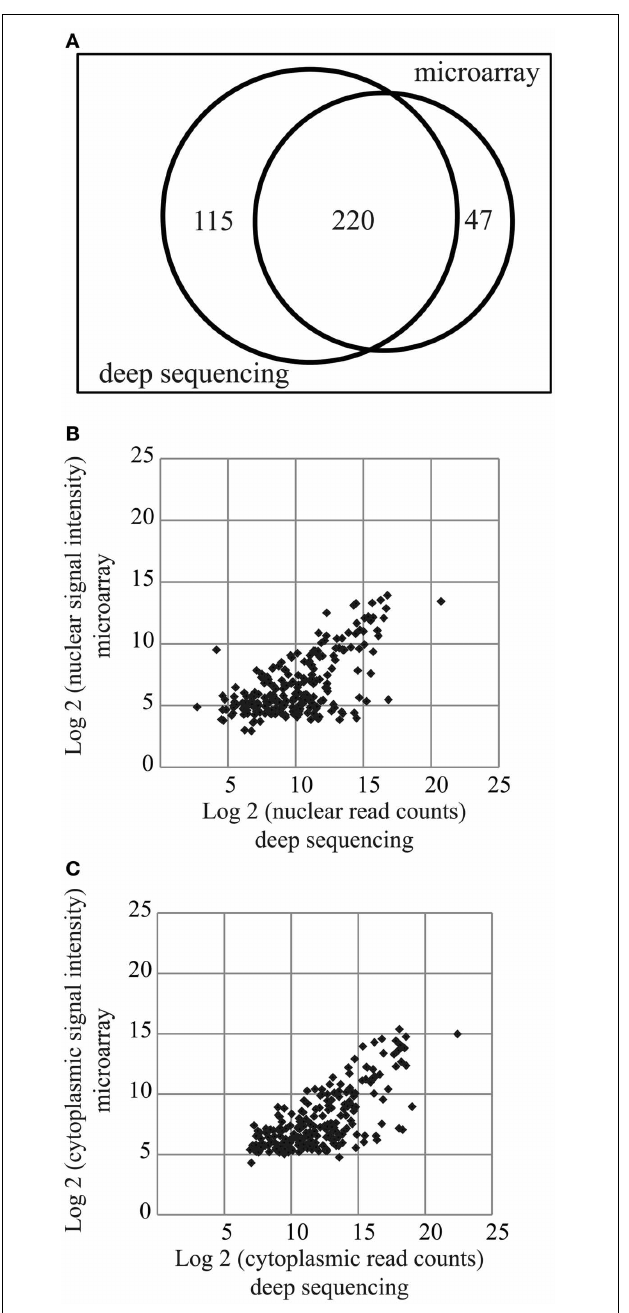
FIGURE 3 | Comparison of miRNA expression profiles obtained from miRNA microarrays and small RNA deep sequencing. (A) Venn diagram illustrating miRNAs detected by the two different methods. 220 miRNAs were detected by both methods. (B,C) Scatterplot of log 2 transformed signal intensity values (microarray, y-axis) and read counts (deep sequencing, x-axis) for miRNAs detected in the nuclear (B) or cytoplasmic (C)